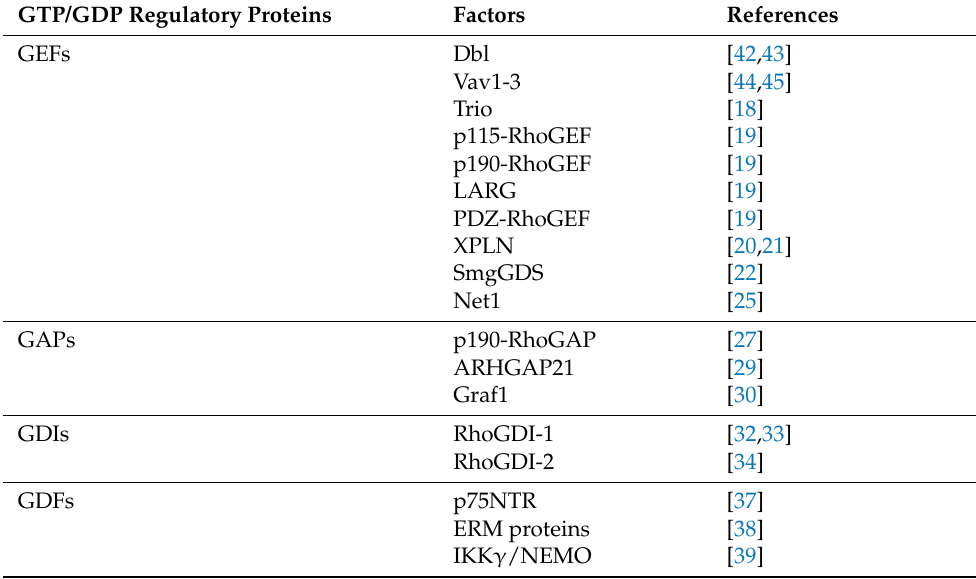
Table 1. Examples of GEFs, GAPs, GDIs, and GDFs targeting RhoA. GTP/GDP Regulatory